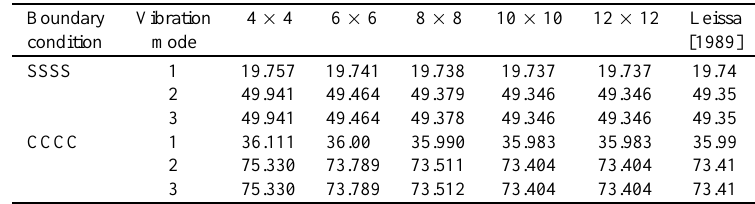
Table 2 Natural frequency parameter of simply supported plate Natural frequency parameter ( ω ) Mode